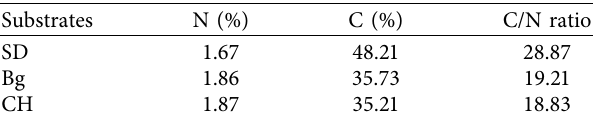
Figure 3: Mycelium growth conditions on Bg, SD, and CH at different growth periods. Table 3: Elemental content of the